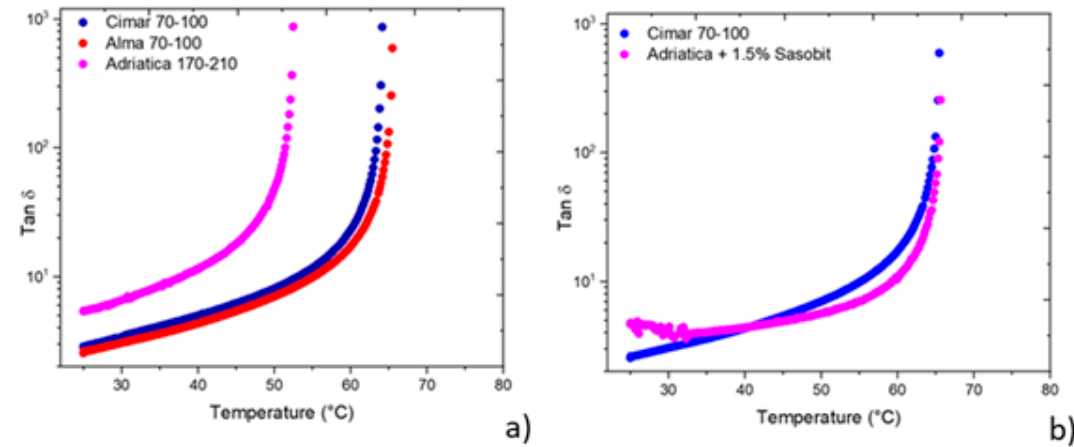
Figure 1. ( a ) Time cure test for Cimar 70–100 (blue); Alma 70–100 (red) and Adriatica 170–210. ( b ) Comparison between the time cure test for Cimar and modified Adriatica with 1.5% SASOBIT.